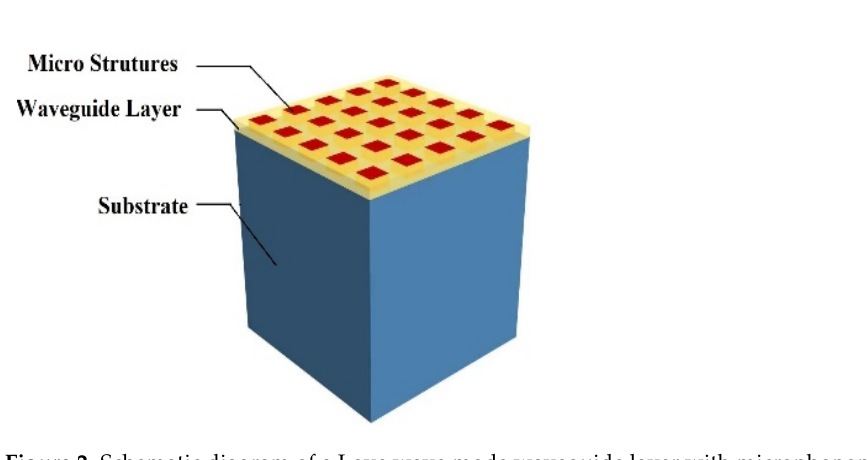
Figure 2. Schematic diagram of a Love wave mode waveguide layer with microphononic crystals. To analyze the Love wave property in the delay line waveguide layer with mi- crophononic crystals, eigen modes and transmission parameters were analyzed, respec- tively. In the eigen mode analysis, a single-cell model was adopted with the finite element method (FEM), and in the transmission parameters analysis, two delay line structures and quasi-three-dimensional models were